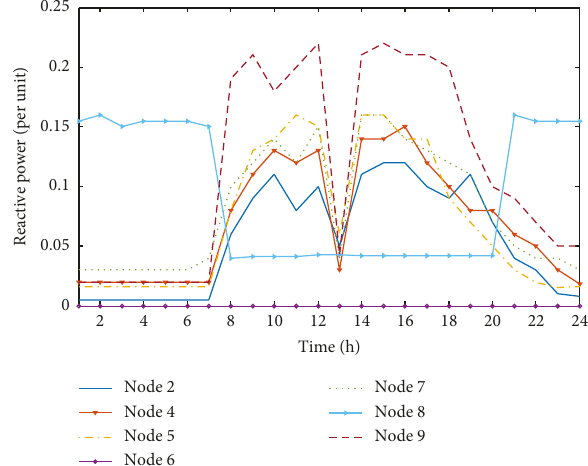
Figure 5: Reactive power data of the load at each node.